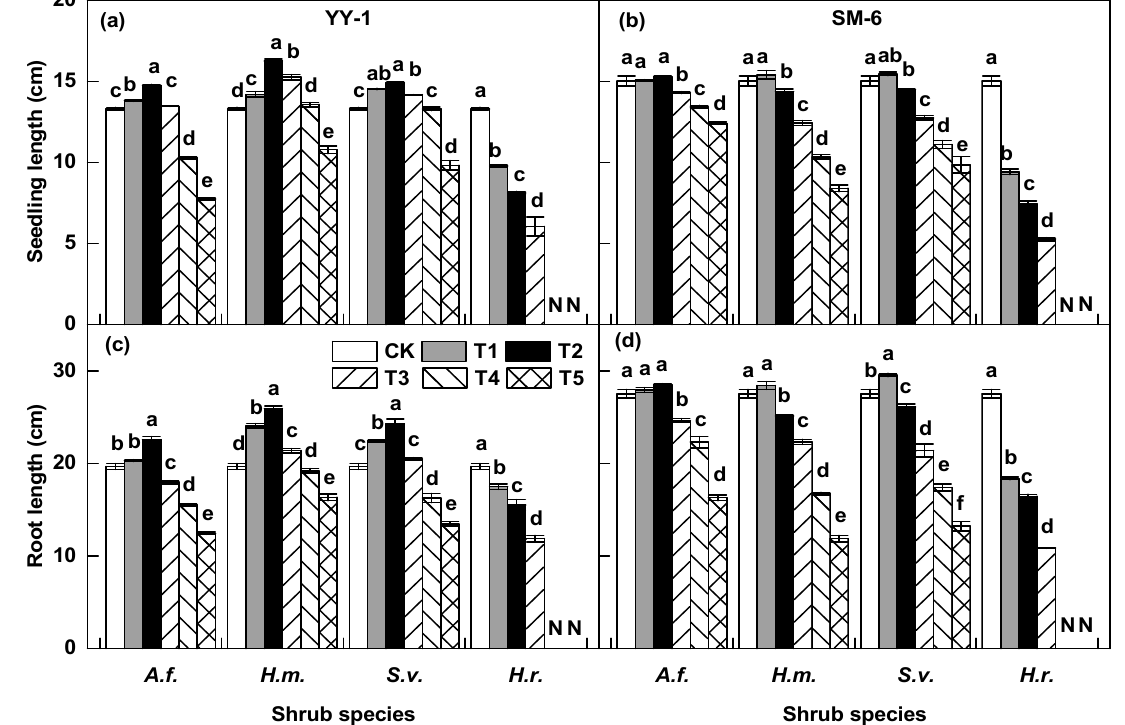
Figure 2. Effect of shrub aqueous leaf extracts on length of seedling and root of Amygdalus pedunculata . ( a – d ). Data (Mean ± Standard Error, n = 42) of the seedling length ( a , b ) and root length ( c , d ) of the target A. pedunculata species of YY-1 and SM-6 exposed to six concentrations 0 (CK), 0.025 (T1), 0.05 (T2), 0.1 (T3), 0.15 (T4), and 0.2 g · mL − 1 (T5) of aqueous leaf extracts from the donor species— Amorpha fruticosa ( A.f. ), Hedysarum mongolicum ( H.m. ), Sabina vulgaris ( S.v. ), and Hippophae